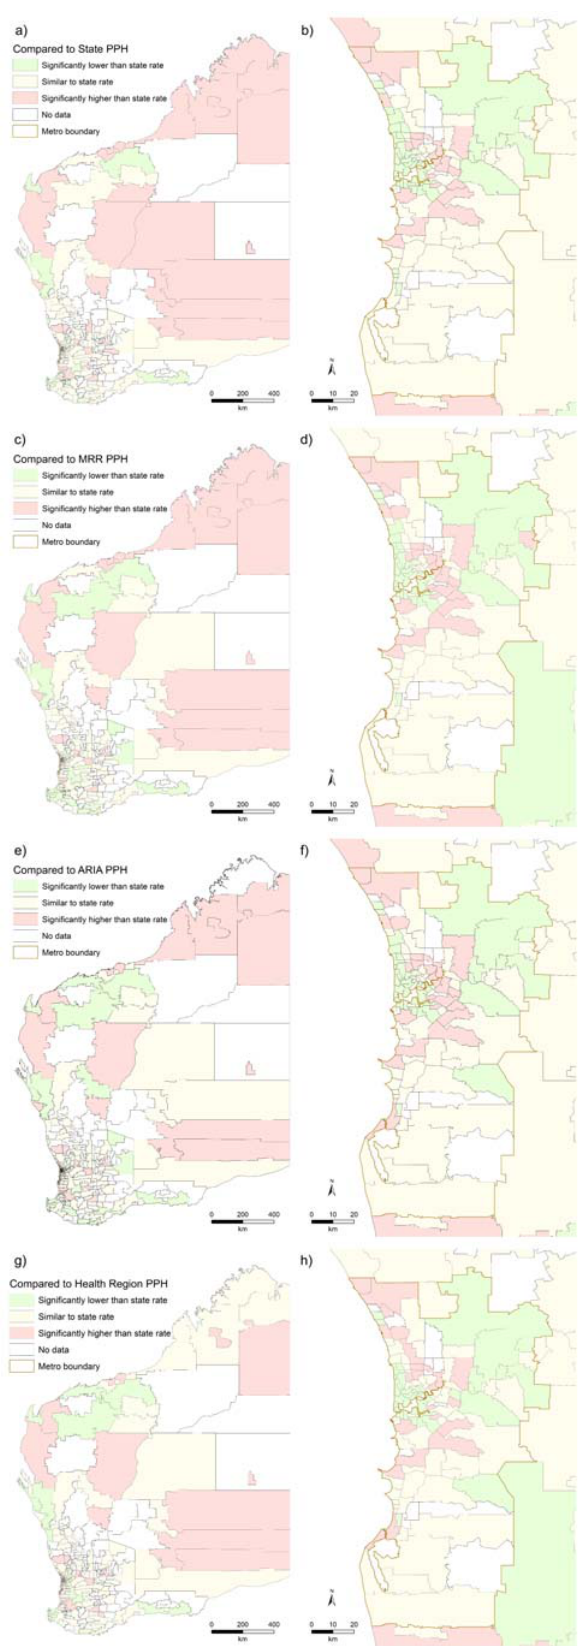
Figure 6. PPH at state and metro scales relative to State (a,b), MRR (c,d), ARIA-based regions (e,f) and Health Regions (g,h)